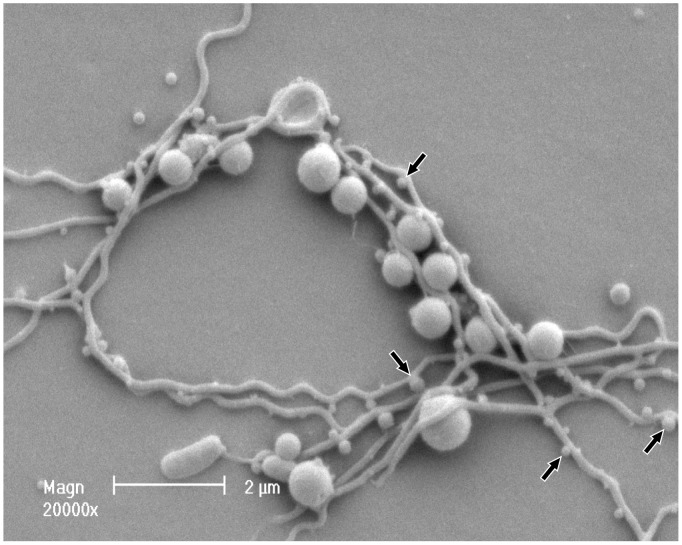
Scanning electron micrograph of P. gingivalis and T. denticola grown in continuous culture.Co-culture was collected, fixed on a coverslip, dehydrated, covered with colloidal silver, gold-coated and imaged using a Philips XL30 field-emission scanning electron microscope. Electron micrographs showed that P. gingivalis and T. denticola coaggregated. T. denticola is a long helical shaped spirochete with an average length of 5 to 20 µm. P. gingivalis is a coccobacillus with an average diameter of 1 µm. Putative T. denticola outer sheath vesicles and/or P. gingivalis outer membrane vesicles are indicated by arrows along the length of T. denticola.